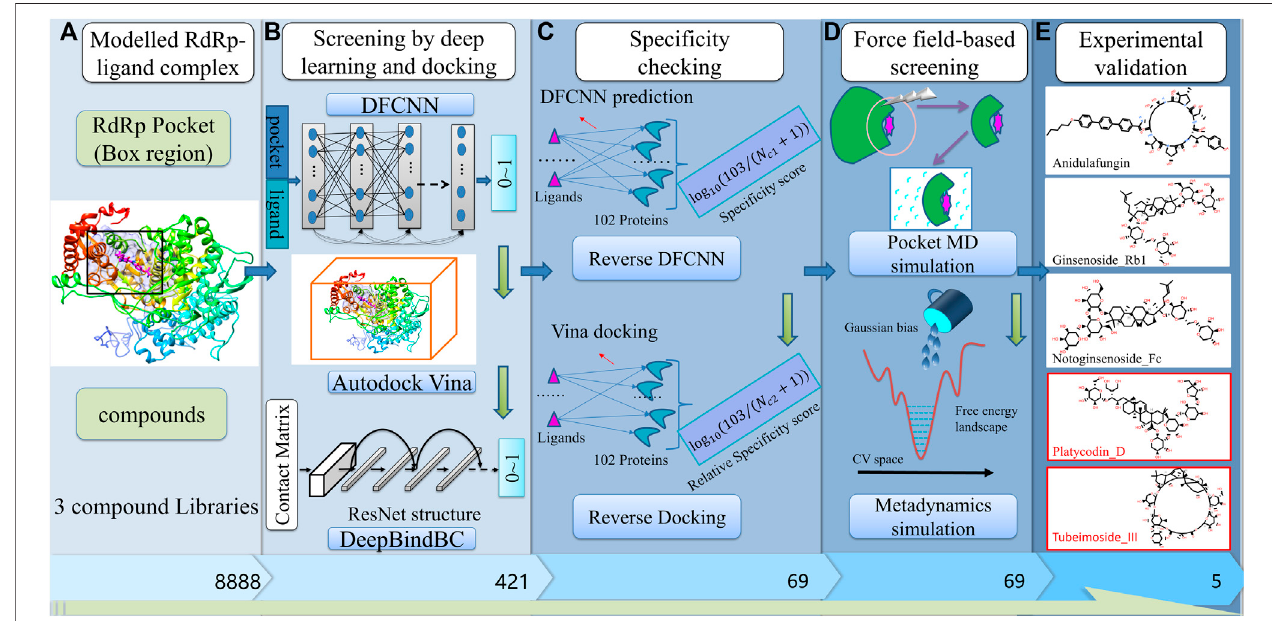
FIGURE 1 | The pipeline of the virtual screening procedure against RdRp. (A) build RdRp-ligand model, and prepare three compounds libraries (Targetmol- Approved_Drug_Library, Targetmol-Natural_Compound_Library, and Targetmol-Bioactive_Compound_Library); (B) Deep learning and docking-based screening by DFCNN, Autodock VinaandDeepBindBC; (C) Speci fi citycheckingbyreverseDFCNN andreverse dockingagainst102diversi fi edtargetsfromDUD.Edataset; (D) Fine screening by pocket MD simulation and Metadyanmics simulation; (E) Experimental validation of fi nal selected